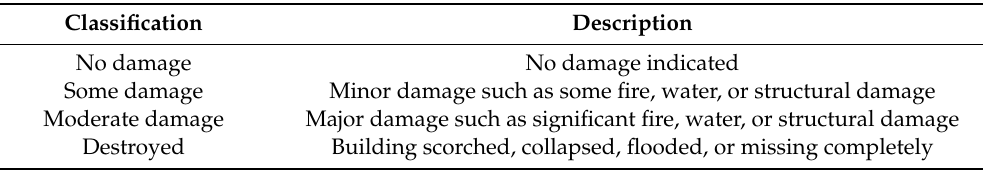
Table 1. Joint damage scale